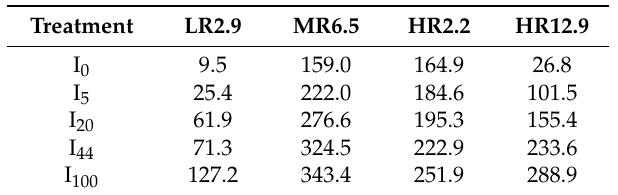
Table 2. Average stand volume (m 3 ha − 1 ) at age 9 for Eucalyptus globulus stands that received different treatments of vegetation control intensity. The study sites were characterized according to their annual mean rainfall (low rainfall (LR), medium rainfall (MR), or high rainfall (HR)) and by the amount of weed biomass produced (Mg ha − 1 ) during the first growing season. Adapted from Vargas et al. 2018 [18].